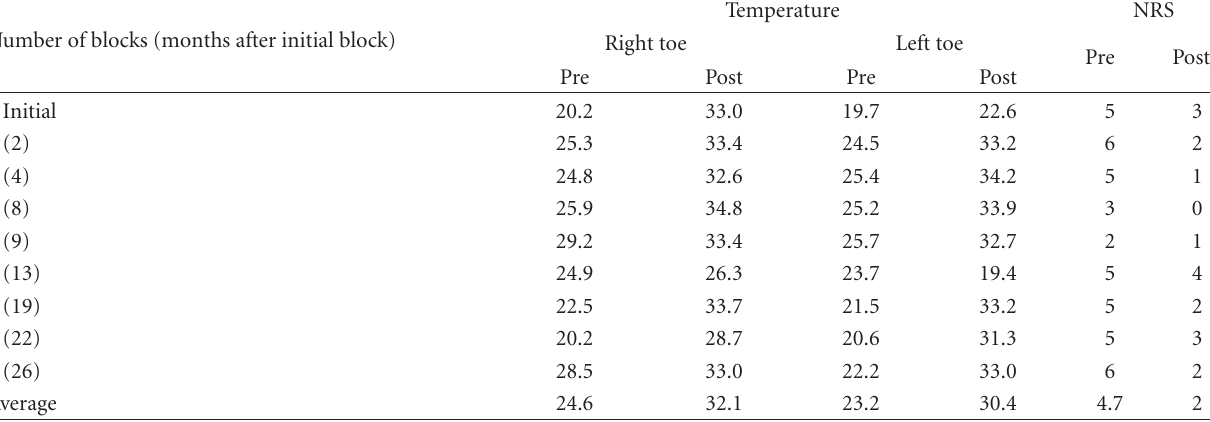
Table 1: Sympathetic block-induced changes in temperature and NRS pain